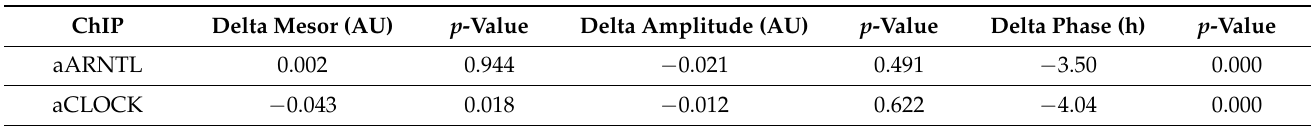
Table 2. ARNTL and CLOCK’s promoter occupancy on the Per1_Ebox was analyzed using Circa- compare [31]. The following parameters were analyzed: mesor, amplitude, phase, and the